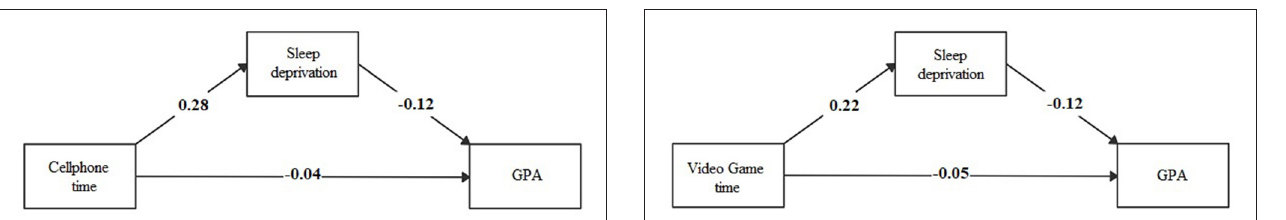
FIGURE 1 | Mediation model of sleep deprivation in the association between time spent during weekdays using cellphone and academic performance (GPA).